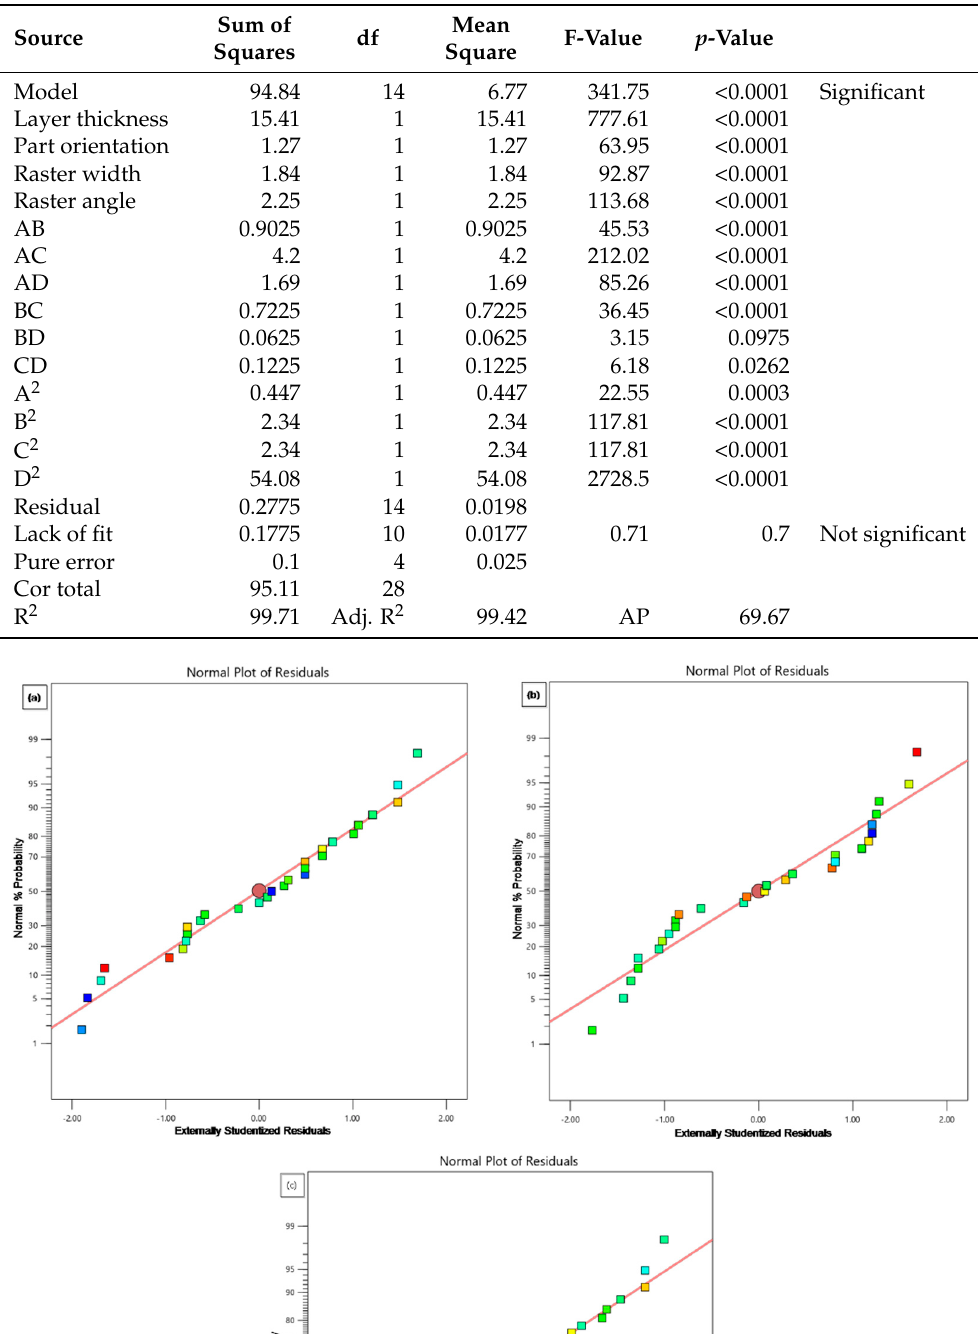
Table 5. Statistical analysis for Rq .